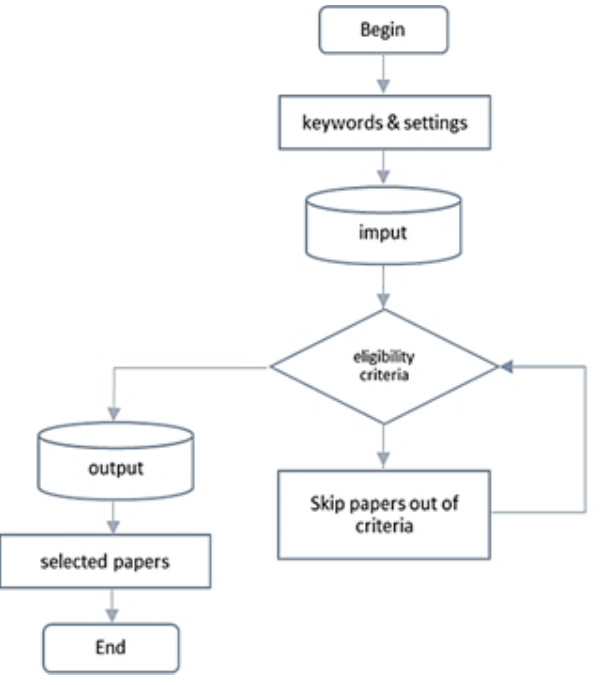
Figure 1. Method